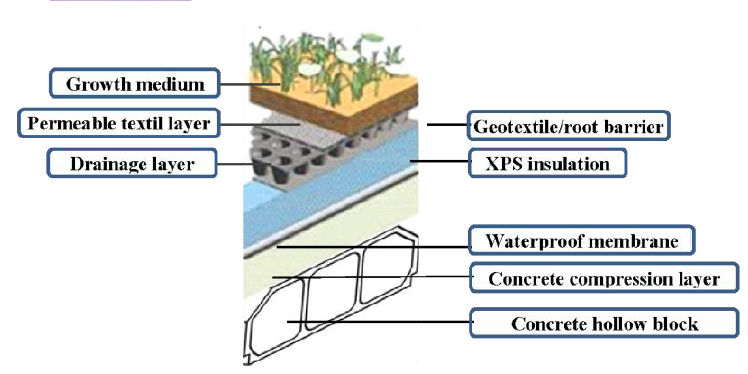
Figure 4. Green roof structure.